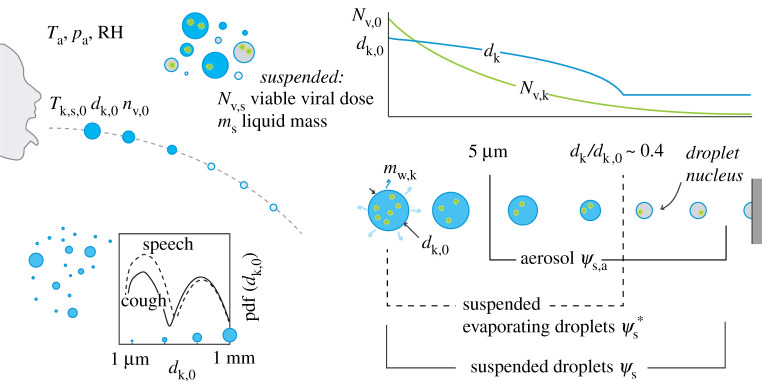
Illustration of the problem and main parameters. (Online version in colour.)